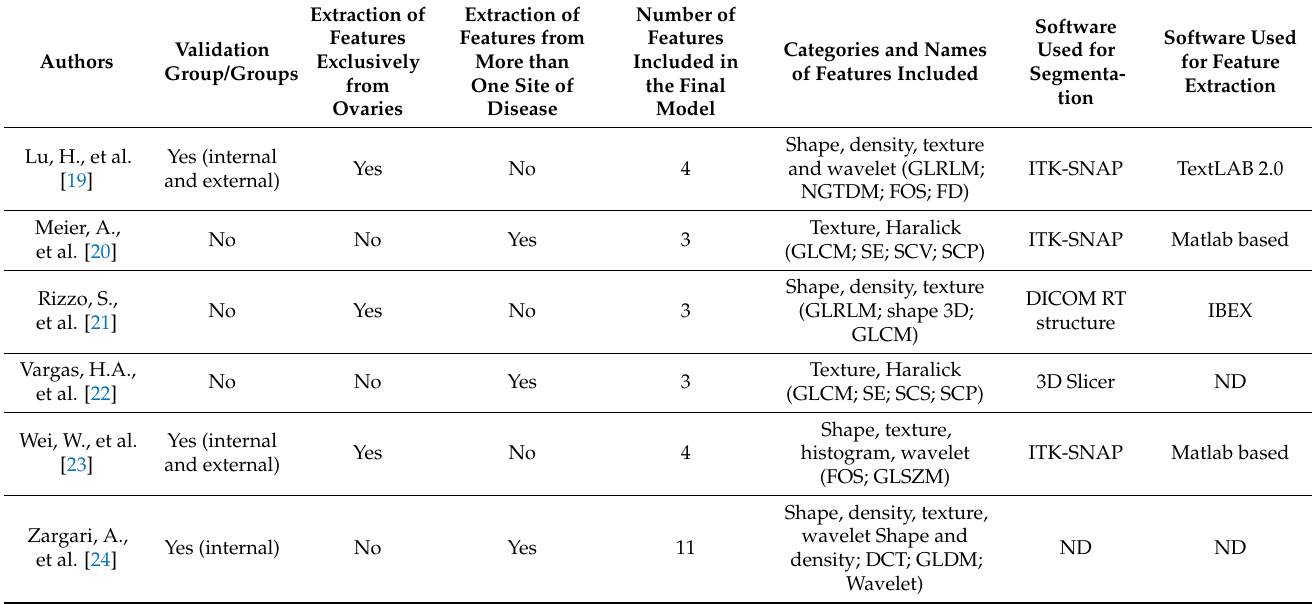
Table 2. Methodological and Technical Aspects of the Included